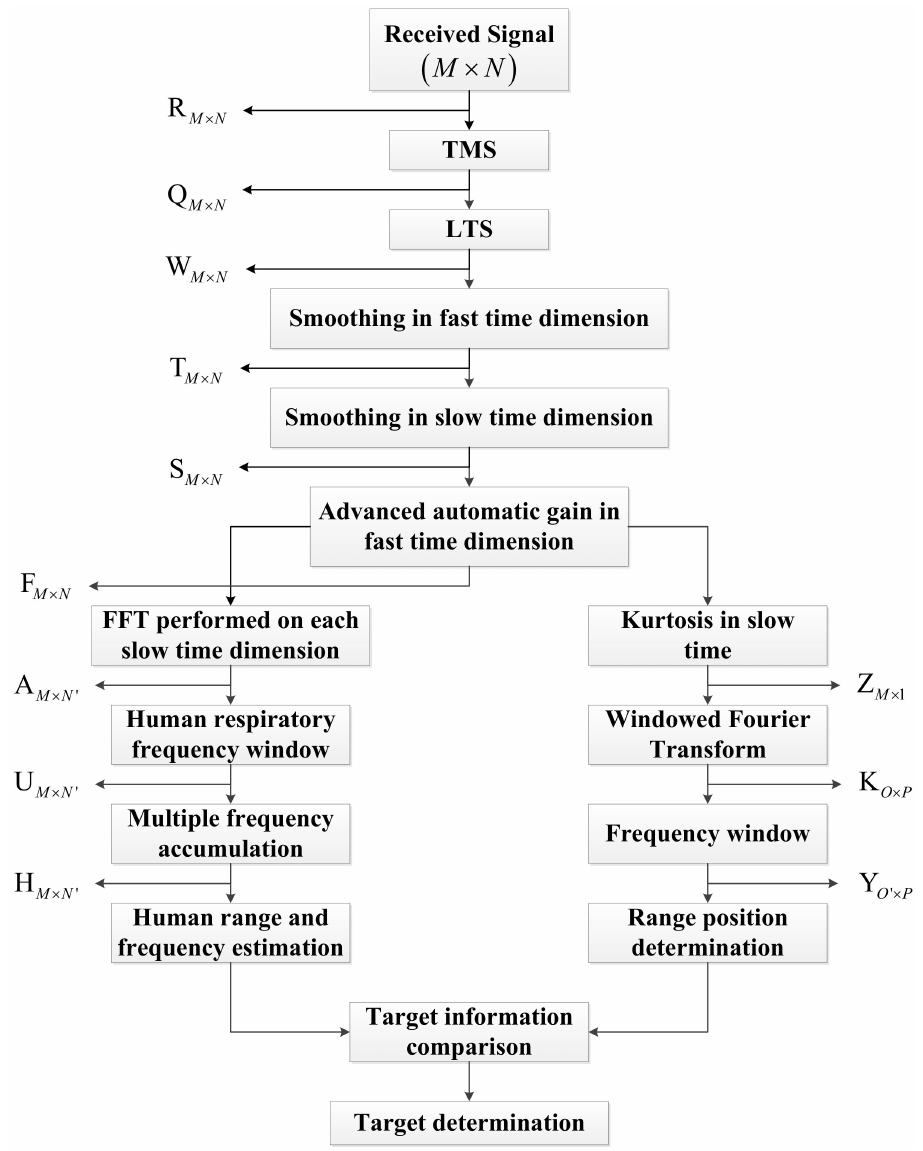
Figure 4. Flowchart of the proposed method for human target